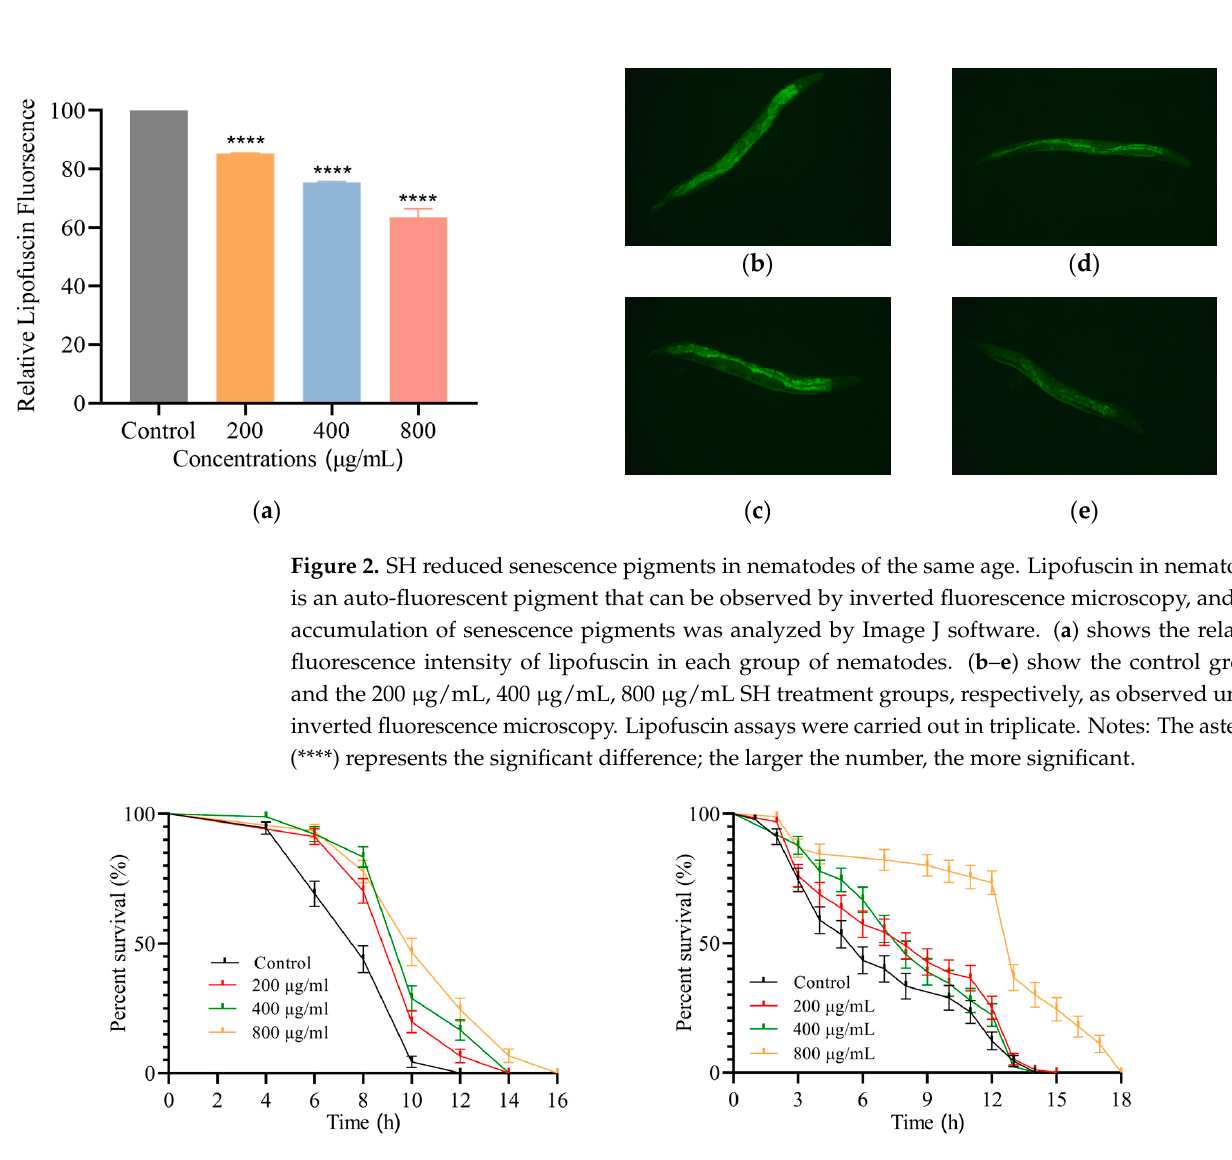
Figure 3. The black curve is the control group and the colored curves are the SH-treated groups. The colored curves in both graphs are shifted to the right, indicating that SH prolongs the lifespan of nematodes under stressful conditions. ( a ) is the survival curve of nematodes under heat shock and ( b ) is the survival curve under H 2 O 2 oxidative stress. Each stress experiment was conducted three times.